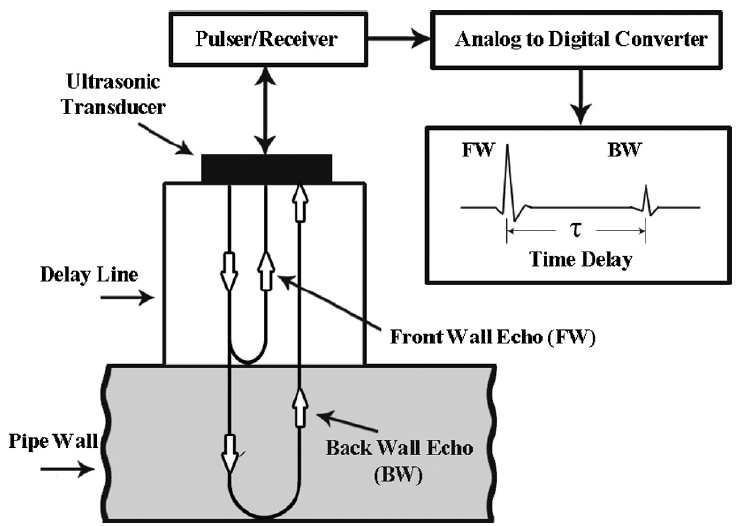
Figure 9. The working principle of an ultrasonic gauge. Reprinted from Ultrasonics, Volume 53, Honarvar, F.; Salehi, F.; Sasfavi, V.; Mokhtari, A.; Sinclair, A.N. Ultrasonic Monitoring of Ero- sion/Corrosion Thinning Rates in Industrial Piping Systems, Page 1251–1258, Year 2013 with permis- sion from Elsevier